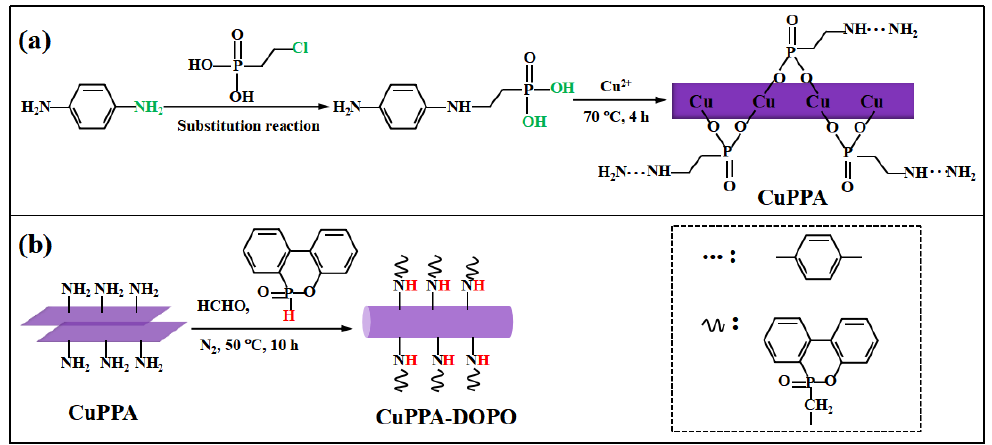
Figure 8. Synthetic route of ( a ) amino phenyl copper phosphate; ( b ) DOPO-amino phenyl cop- per